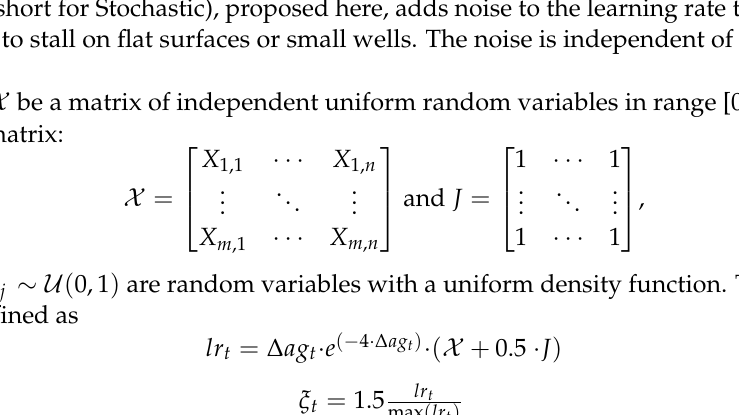
Figure 3. The plot of Equation (35).